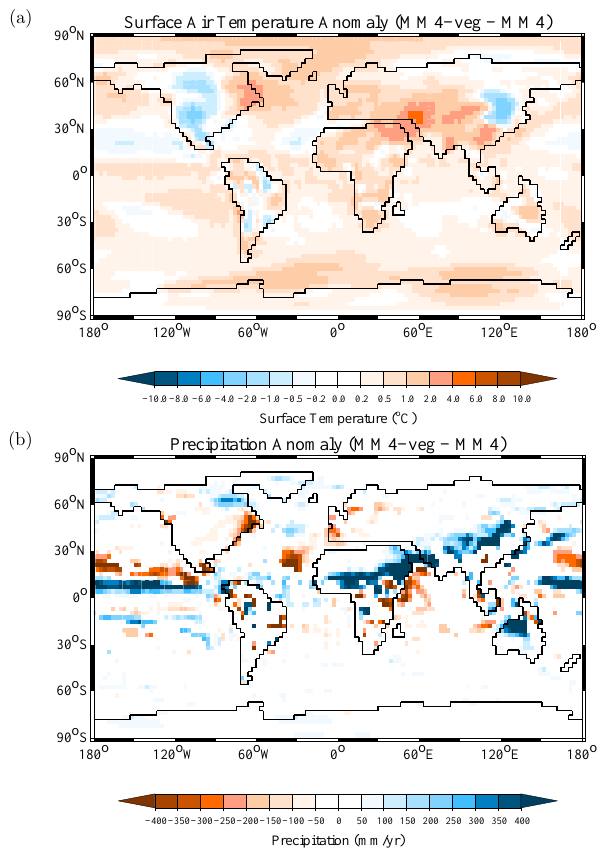
Fig. 18. (a) Annual mean surface temperature and (b) precipitation anomalies between experiment MM4-veg and MM4.